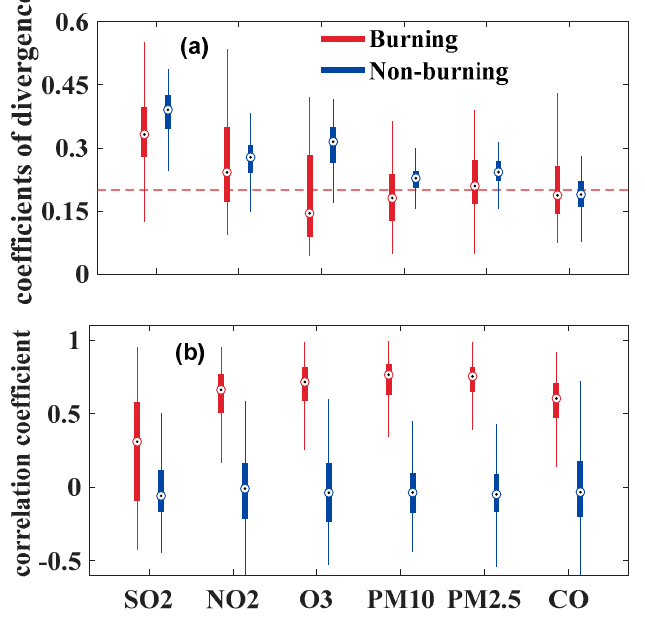
Figure 6. Overall inter-site COD ( a ) and R ( b ) of SO 2 , NO 2 , O 3 , PM 10 , PM 2.5 and CO for the burning and non-burning periods. The horizontal dotted line indicates the COD value of 0.20 in subplot ( a ).